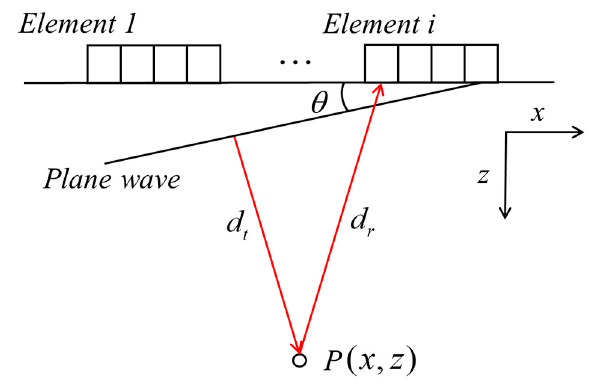
Figure 1. Reception at element i while θ plane wave emitting.